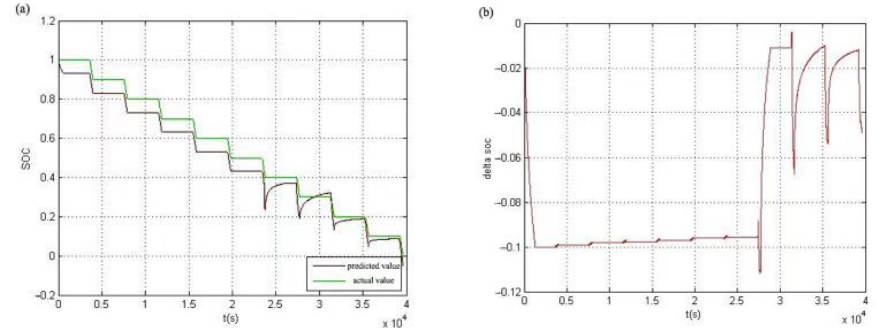
Figure 10. Comparison chart of ( a ) predicted SOC and actual value; ( b ) the difference through discharge OCV test.